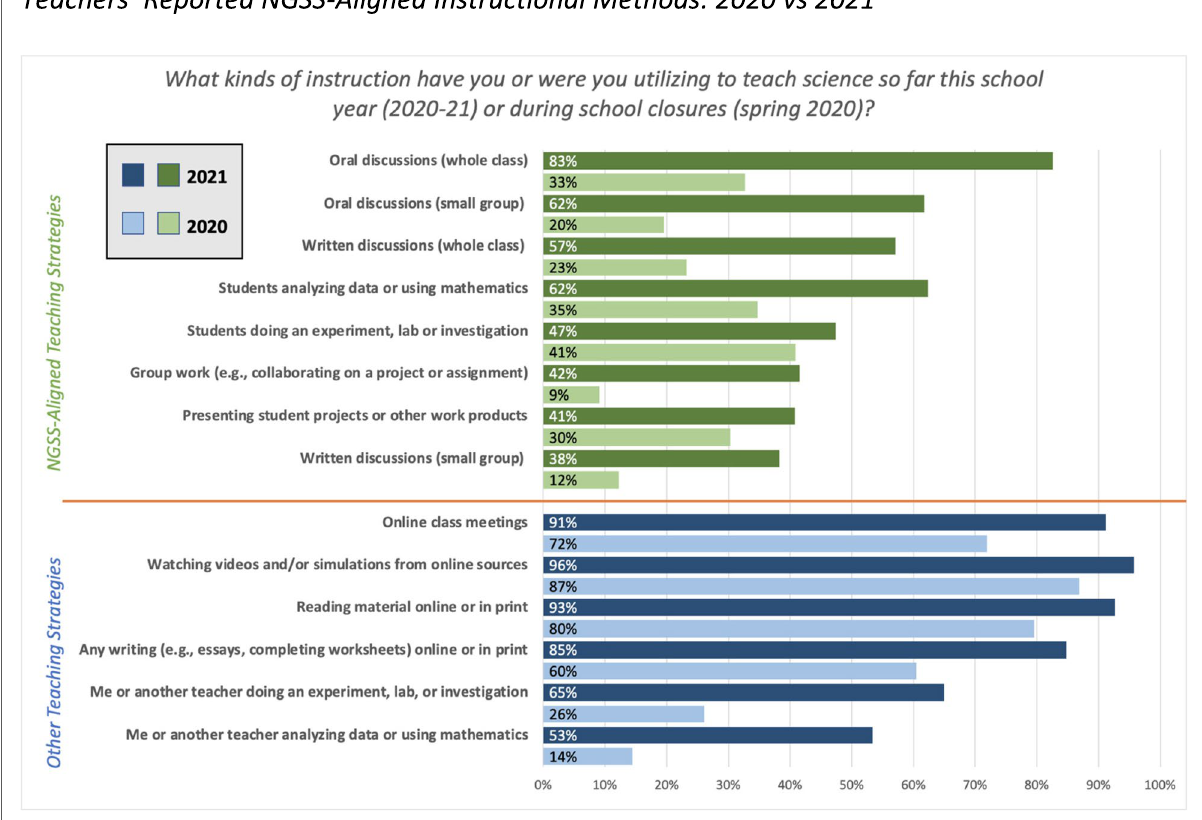
Fig. 3 Teachers’ Reported NGSS-Aligned Instructional Methods: 2020 vs